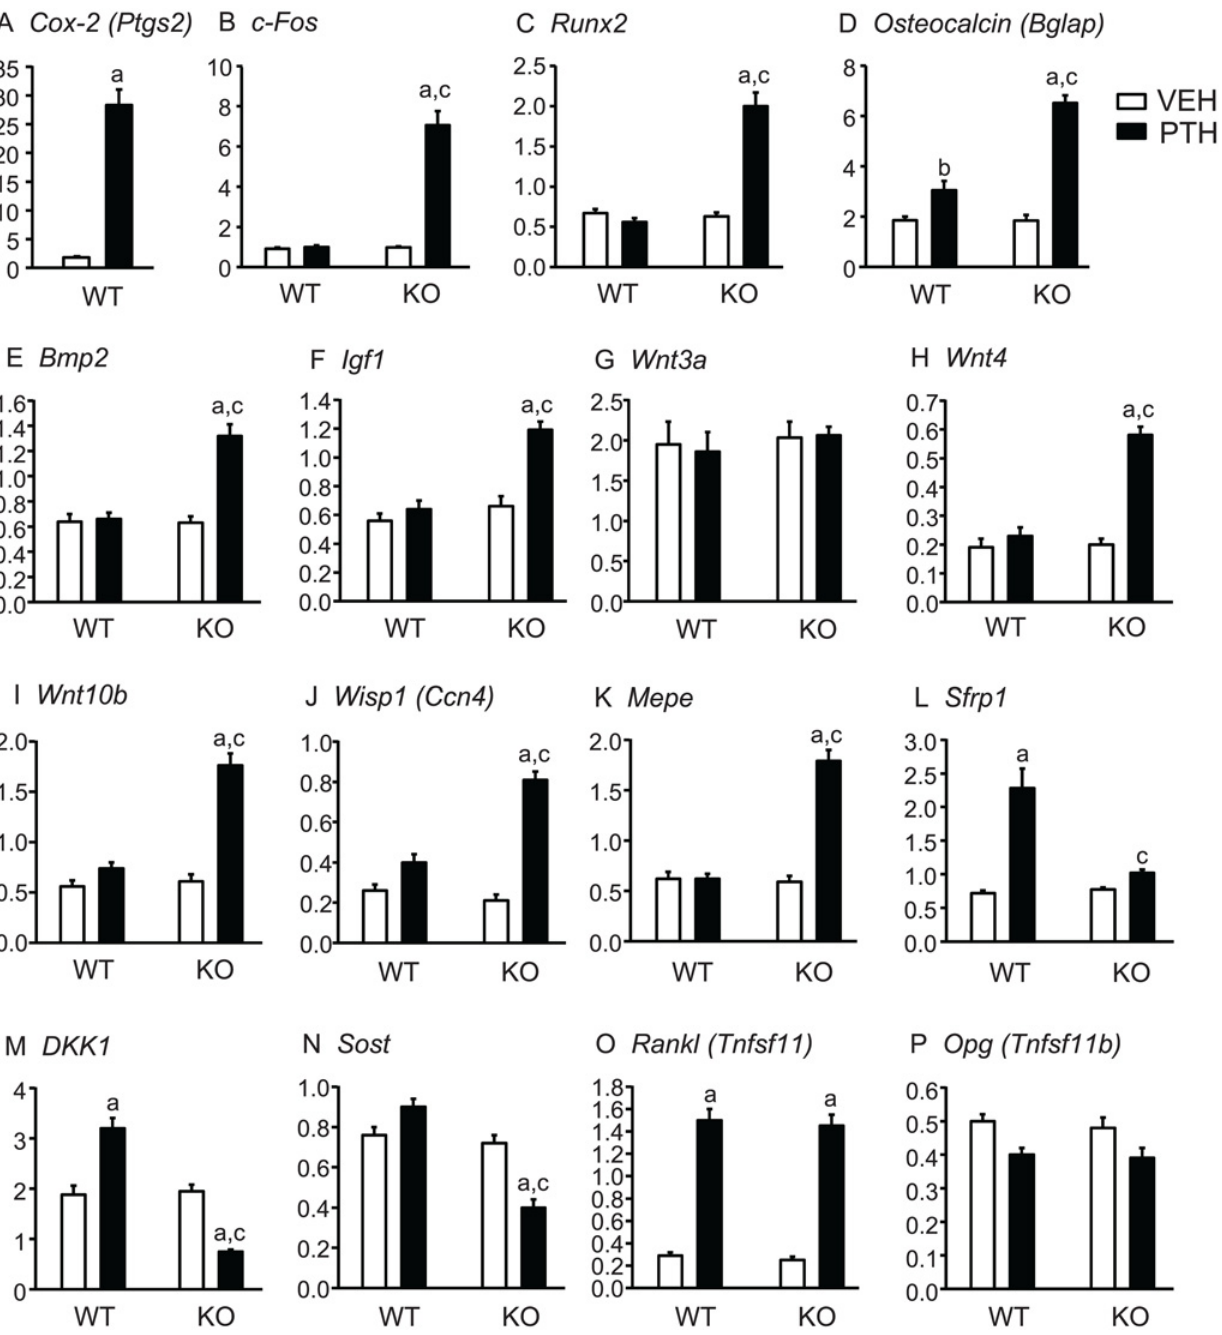
Fig 4. Tibial gene expression in mice infused with vehicle or PTH for 12 days. At the end of infusion, both tibiae from each mouse, minus ends, were combined for RNA extraction. mRNA expression was measured by qPCR, as described in Methods. Bars are means ± SEM for 7 WT and 7 KO mice infused with vehicle and 8 WT and 8 KO infused with PTH. a Significant effect of PTH, p < 0.01; b p < 0.05. c Significant effect of genotype, p < 0.01.